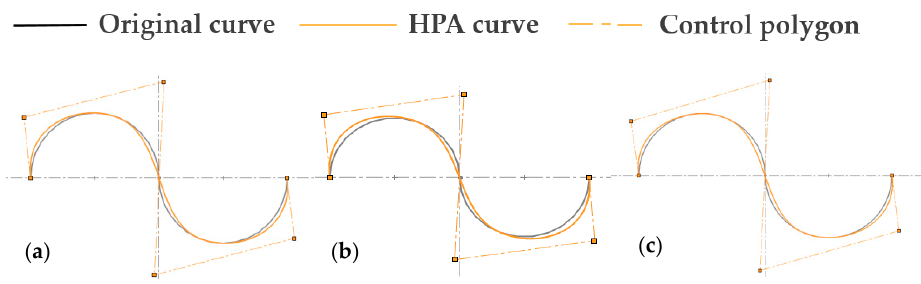
Figure 7. Influence of population size W on curve fitting, ( a ) W = 10, ( b ) W = 20 and ( c ) W = 50 .